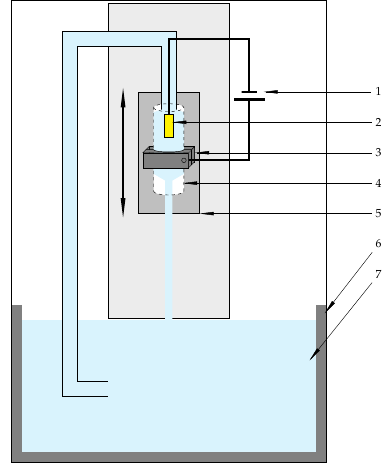
Figure 1. Schematic design of a plasma polishing system for internal pipe surfaces [22]: (1) direct current (DC) power supply, (2) polishing head (cathode), (3) tube clamping, (4) tube (anode), (5) spindle drive with vertical axis, (6) basin, (7)